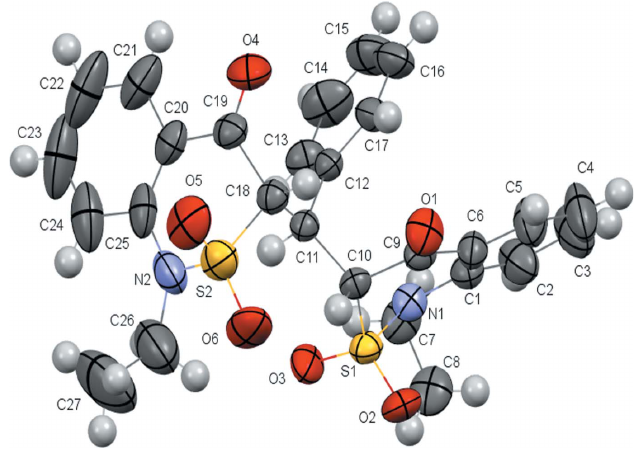
Figure 5 Molecular structure of the compound 7C( R , R , S ) . Only the major component of disorder is shown. Displacement ellipsoids are shown at the 50% probability level.